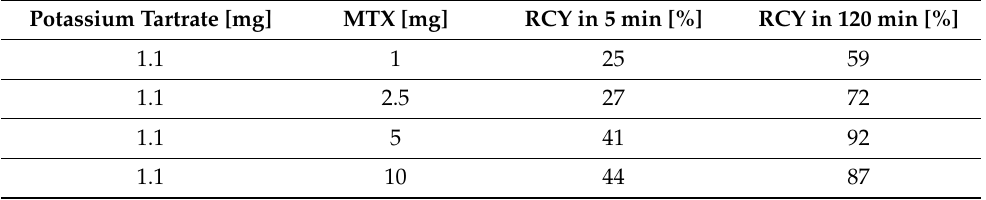
Table 4. Radiolabelling yield of [ 99m Tc]Tc-MTX radiocomplex relative to the amount of MTX and time.